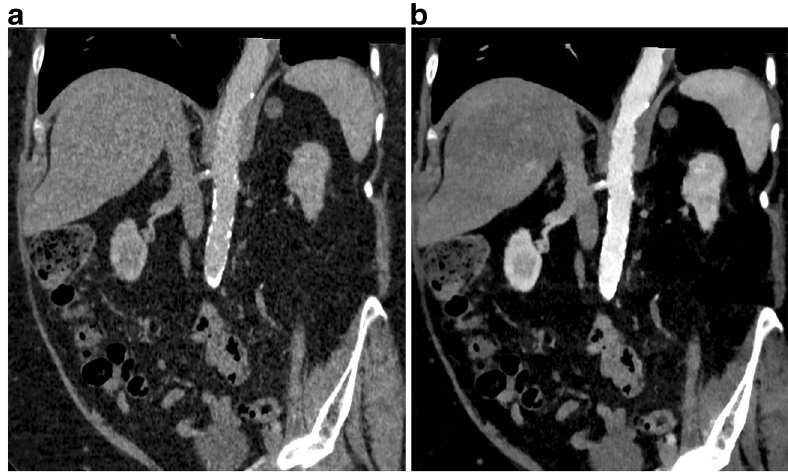
Fig. 4 Low-contrast dose study. ( a ) Coronal 120-kVp routine diagnostic CTA image in a patient who received only 20 ml of intravenous contrast, shows poor contrast opacification of the abdominal aorta as well as parenchymal organs. ( b ) 40 keV VMI at the same level shows significant improvement of vascular contrast in the abdominal aorta. Thus, the low-energy VMI allows the use of low contrast dose, which is valuable in patients with severe renal